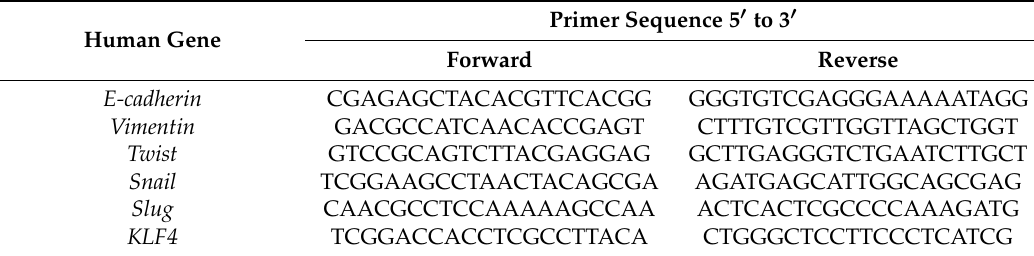
Primer Sequence 5 (cid:48) to 3